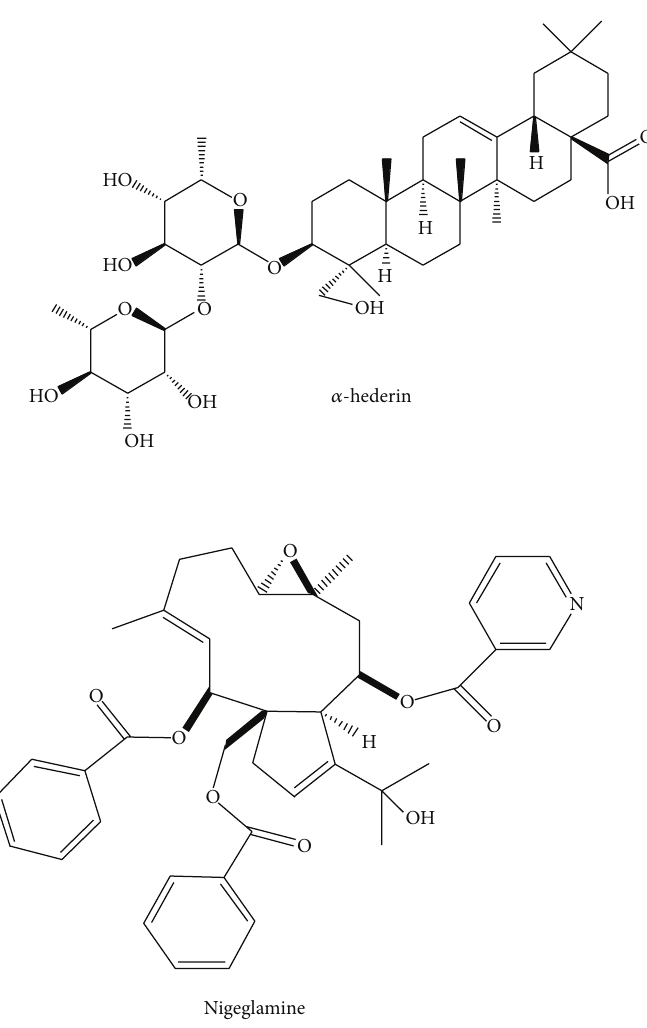
Figure 1: Chemical structures of selected compounds isolated from Nigella glandulifera Freyn et Sint